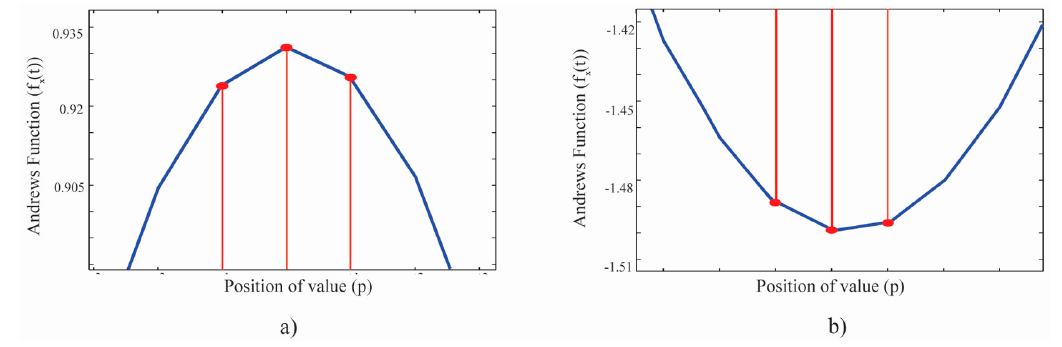
Figure 4. Examples of ( a ) positive and ( b ) negative peaks from Andrews’ curves.